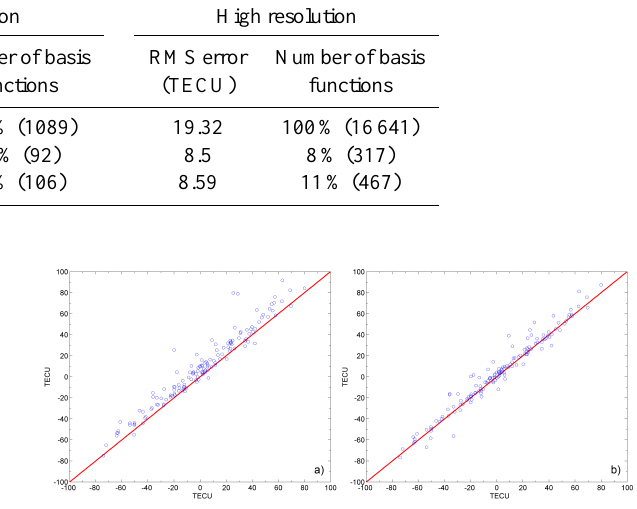
Figure 6. Scatter plot of the estimated offsets ( y axis) versus the true offsets ( x axis) with (a) spherical harmonics and (b) discrete Meyer at low resolution.